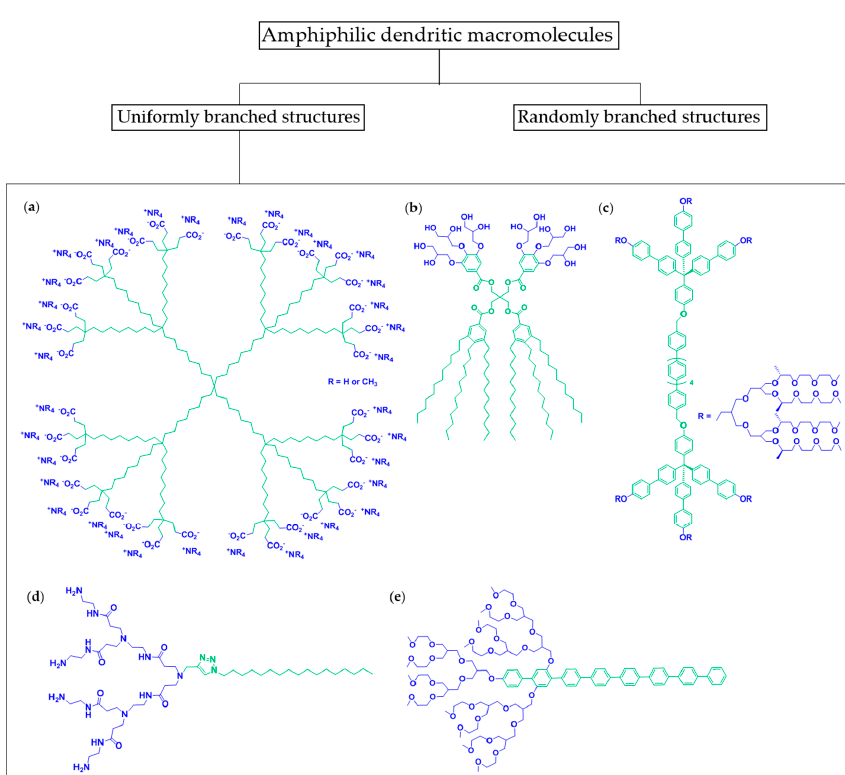
Figure 1. Examples for each sub-group of uniformly branched dendritic macromolecules: ( a ) amphiphilic dendrimer [28]; ( b ) amphiphilic JD [21]; ( c ) amphiphilic dumbbell [34]; ( d , e )